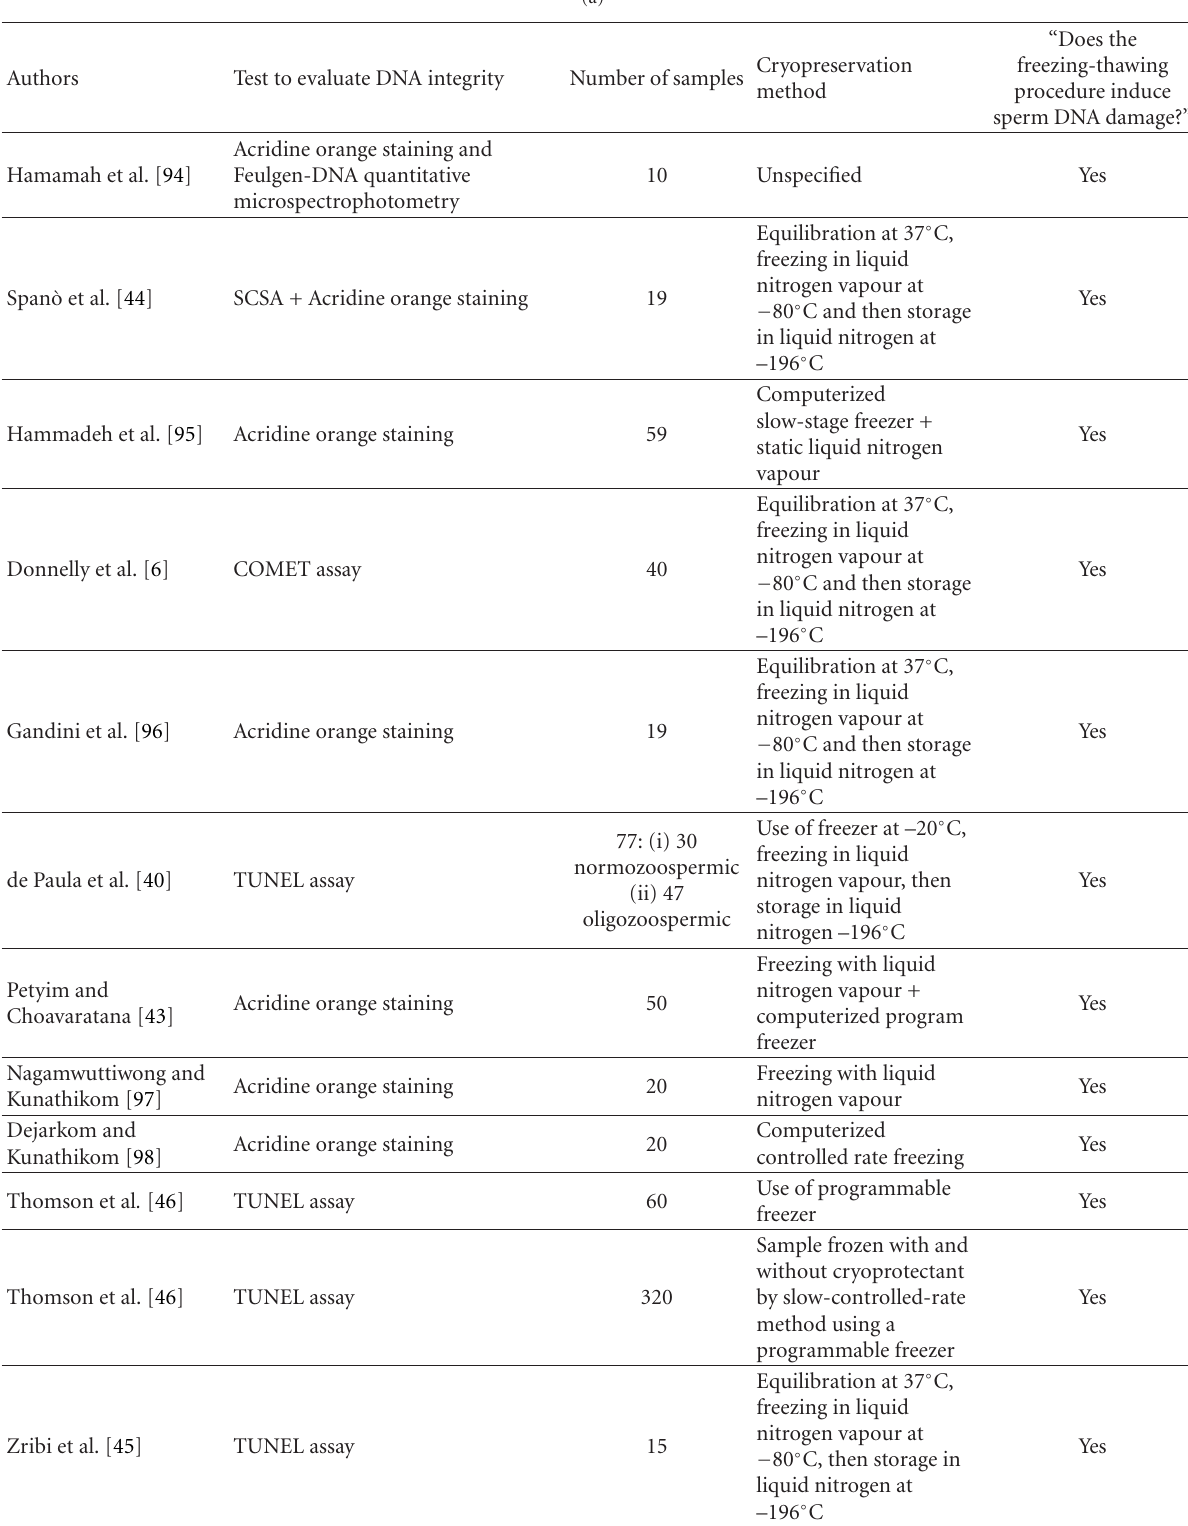
Table 2: (a)–(c) Evaluation of DNA integrity after cryopreservation: description of the experimental design and